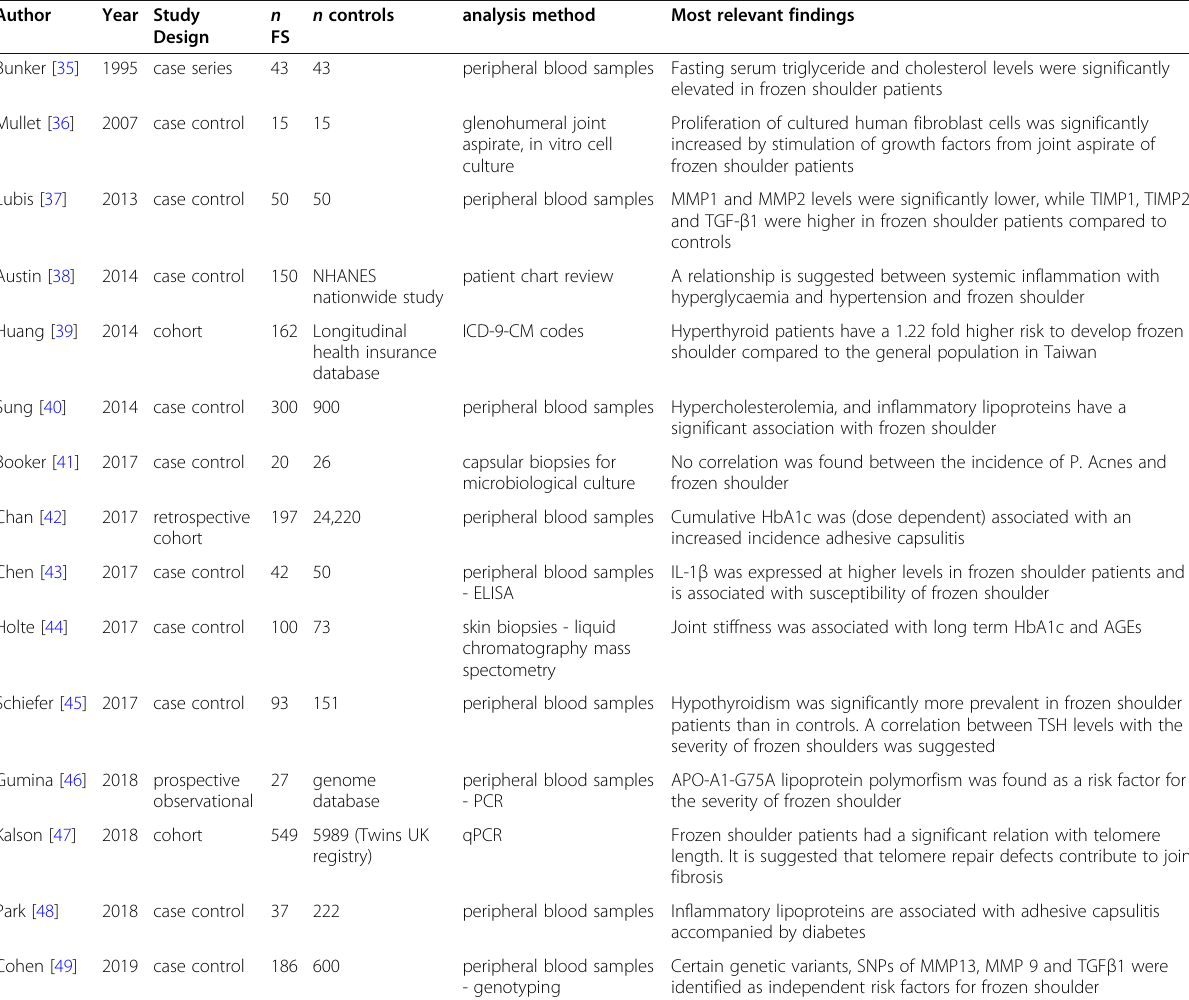
Table 2 Association studies; studies investigating the association between frozen shoulder and a co-morbidity, focussed on the pathophysiologic mechanism